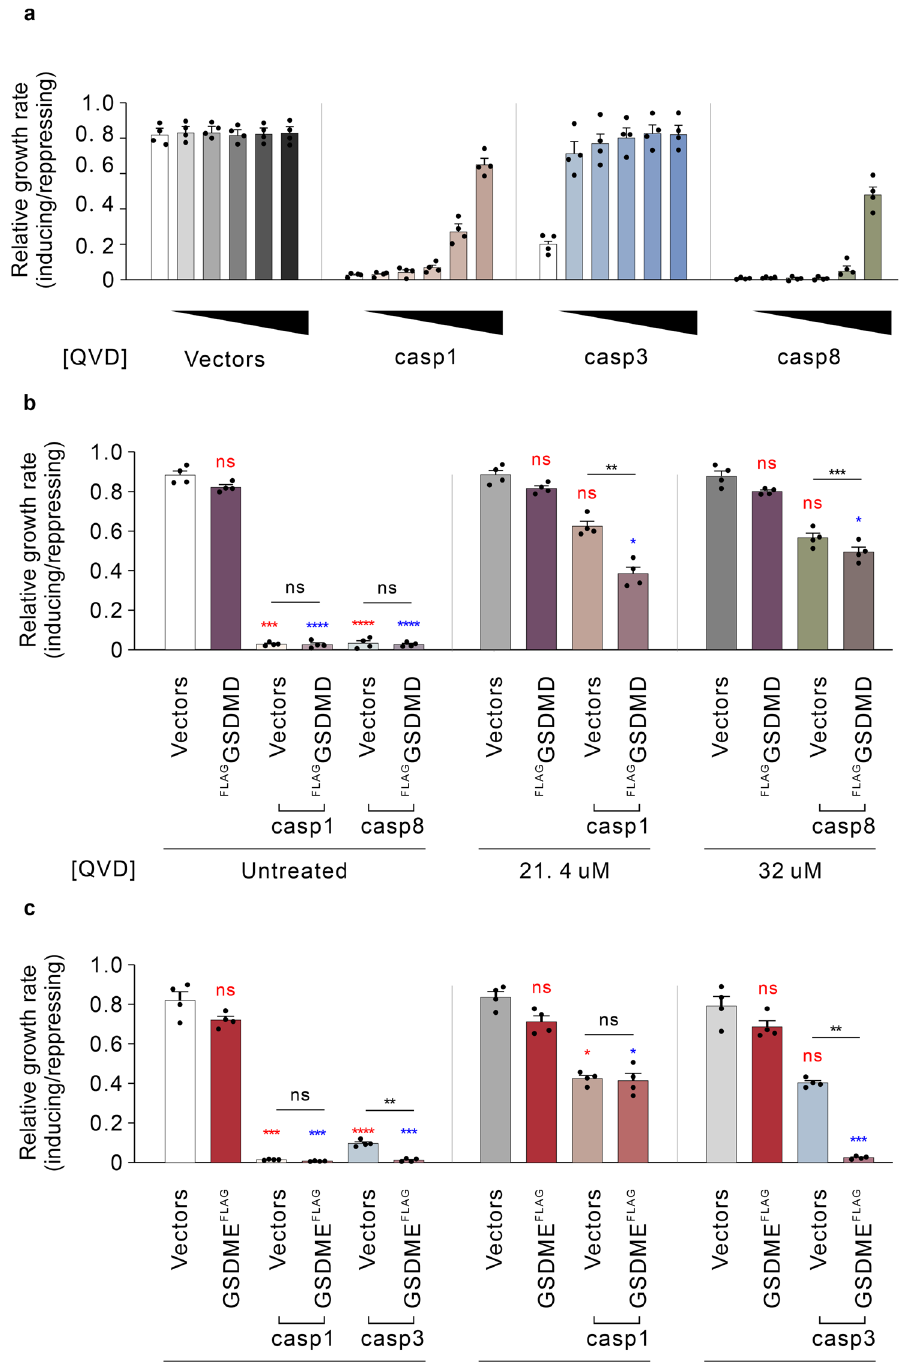
Figure 4. Inhibition of active caspase-induced yeast lethality expanded the applicability of the yeast expression system modeling pyroptotic cell death . (a) Maximal growth rates of yeast bearing expression plasmids encoding active caspases-1, -3, or -8, or bearing empty vectors lacking cell death genes (labeled “Vectors”), were analyzed by monitoring rate of changes in absorbance of yeast cultured in inducing and repressing liquid media with 0, 2, 4, 8, 16 or 32 µM of the small molecule pan- caspase inhibitor QVD. Differences in maximal growth rates of yeast bearing expression plasmids encoding ( b ) FLAG GSDMD and active caspase-1, or -8; or ( c ) GSDME FLAG and caspase-1, or -3, in media containing 1% DMSO with either no drug (untreated) or containing QVD at approximately half maximal inhibitory concentrations, were compared. Differences in maximal growth rates of yeast expressing empty vector versus those expressing each transgene, or sets of 2 transgenes versus individual transgenes were compared using ANOVAs with Sidak corrections. Comparisons were made between yeast exposed to the same QVD treatments. Comparisons between yeast expressing each transgene(s) and empty vector yeast are labeled in red; Comparisons between each transgene(s) to yeast expressing FLAG GSDMD ( b ) or GSDME FLAG ( c ) are labeled in blue. Other comparisons are indicated using black lines. *, P < 0.05; **, P < 0.01; ***, P < 0.001; ns, not